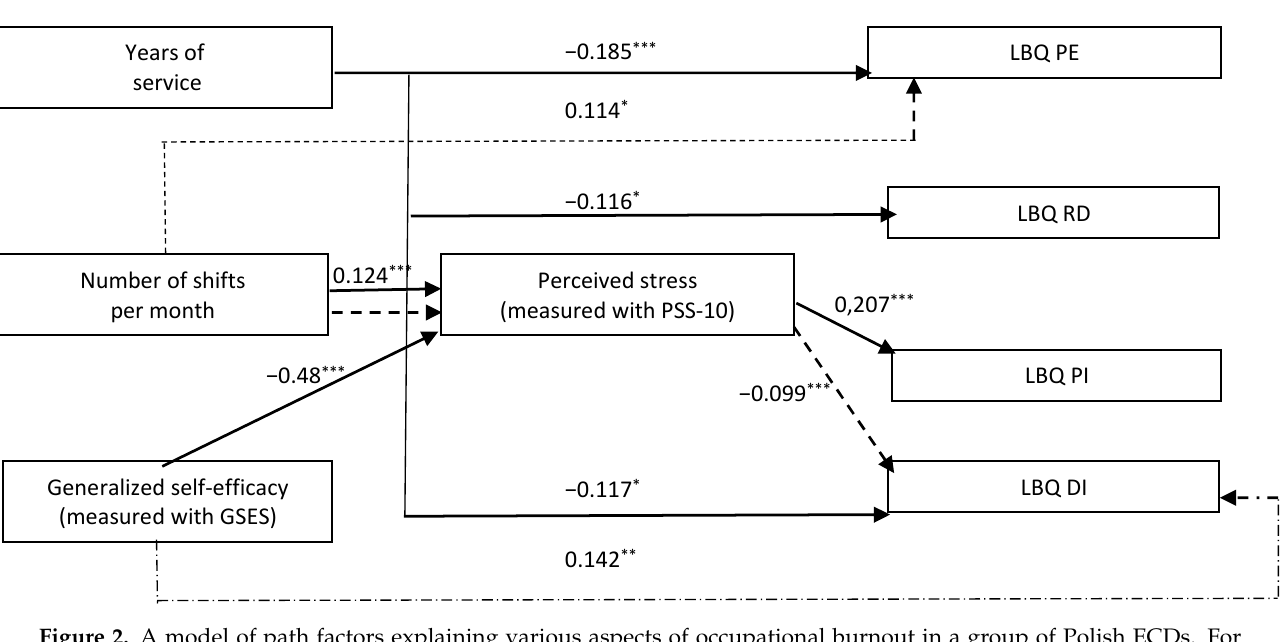
Figure 2. A model of path factors explaining various aspects of occupational burnout in a group of Polish ECDs. For the readability of the graph, the graphic markings of irrelevant paths were omitted. *** Statistical significance < 0.001; ** statistical significance < 0.01; * statistical significance < 0.05. GSES-GSES—General Self-Efficacy Scale, PSS-10—Perceived Stress Scale, LBQ—Link Burnout Questionnaire: PE—psychophysical exhaustion, RD—relationship deterioration, PI—sense of professional inefficacy, DI—disillusion. Table 4. Standardized results of regression analyses performed on the total effect, direct effect and indirect effect in group of Polish ECDs (N =